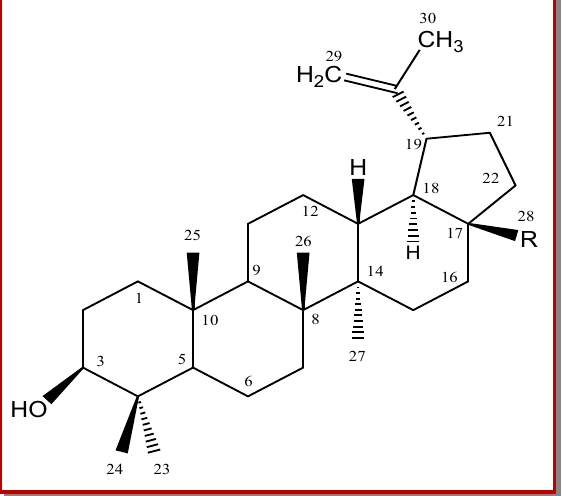
Figure 2: Chemical structure of stigmasterol